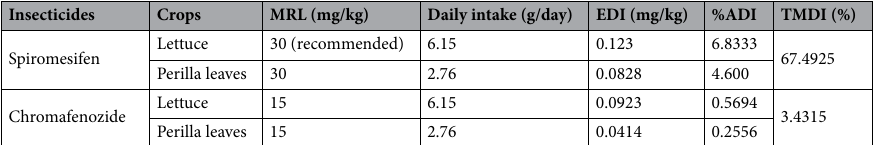
Table 4. TMDI and %ADI of spiromesifen and chromafenozide in lettuce and perilla leaves. MRL maximum residue limit, EDI estimated daily intake, TMDI theoretical maximum daily intake.